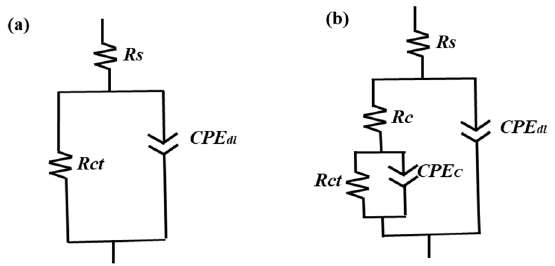
Table 4. Fitting impedance parameters of each sample after soaking at 80 °C.